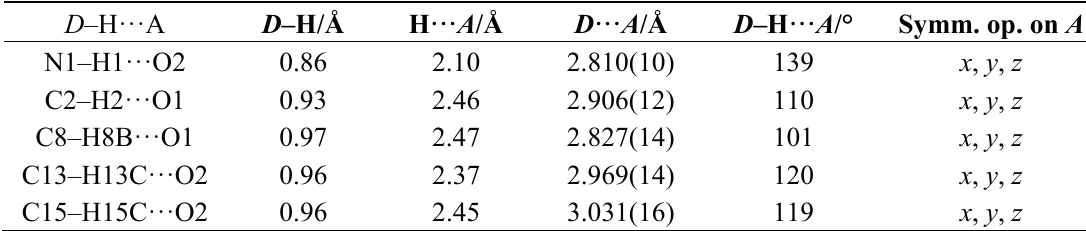
Table 6. Geometric parameters of hydrogen bonding.